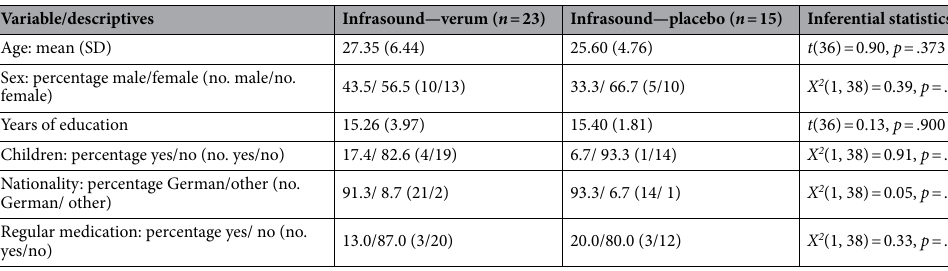
Table 1. Descriptive sample data and between-group differences for socio-demographic